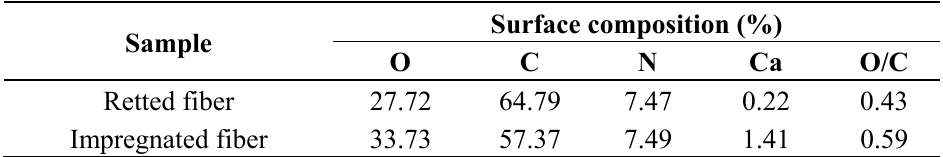
Table 1. Surface composition of inorganic nanoparticle impregnated (INI) kenaf bast fibers with chemically retted fibers used as